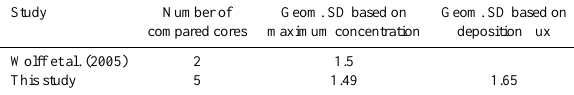
Table 3. Statistics on sulfate signal for identical peaks in cores 1, 2, 3, 4 and 5. Geometric standard deviations are calculated on peak heights (i.e., maximum concentration reached in nanograms per gram) and on peak sulfate flux (i.e., total mass of volcanic sul- fate deposited after the eruption). Background corrections are based on background values calculated separately for each volcanic event. Geom. SD based